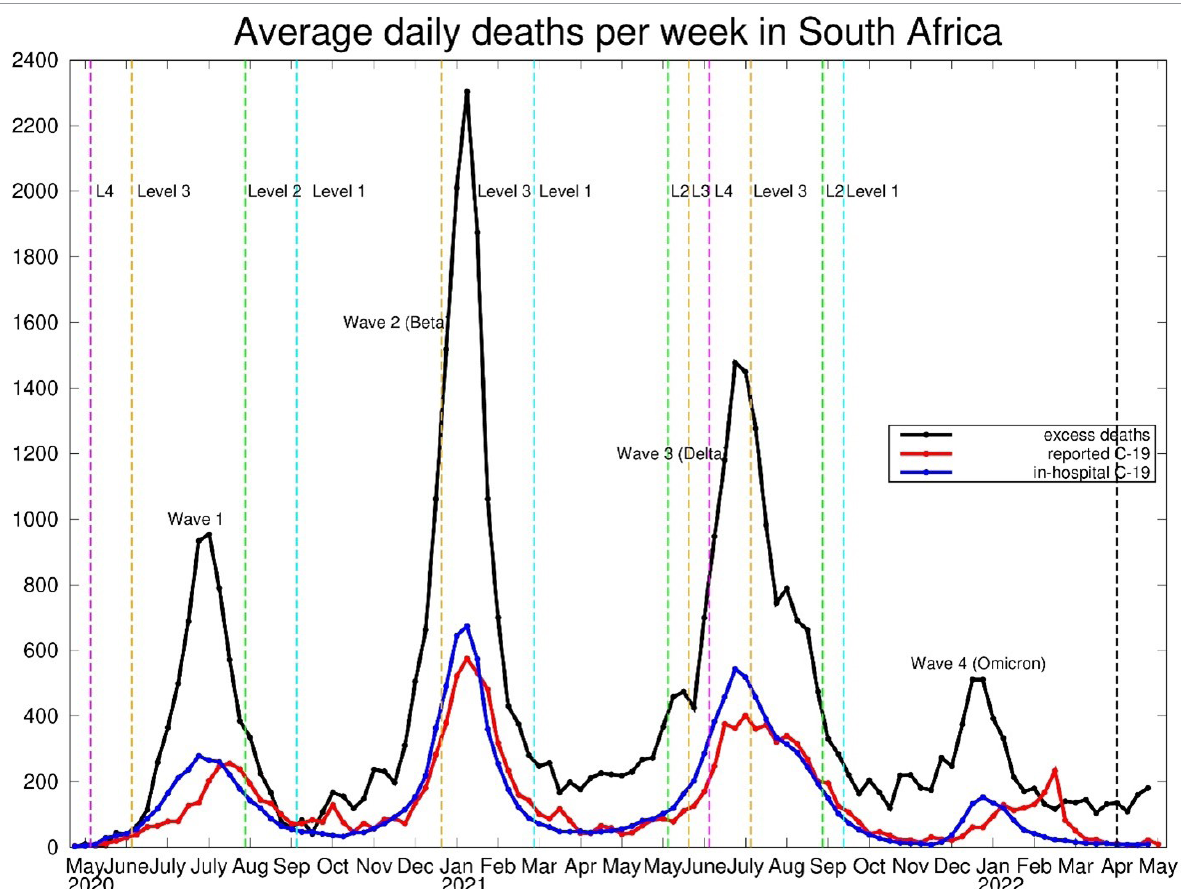
Figure 4: Mortality rates during the COVID-19 pandemic in South